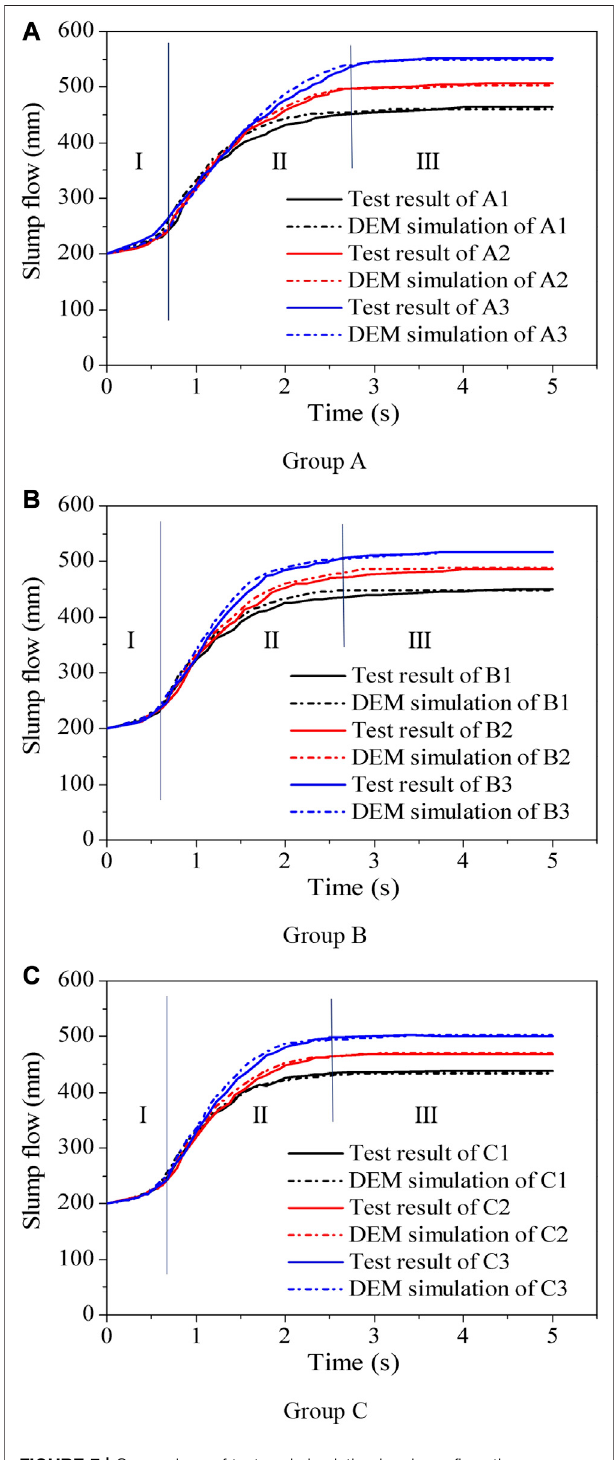
FIGURE 7 | Comparison of test and simulation by slump fl ow – time curves: (A) Group A, (B) Group B, and (C) Group C.